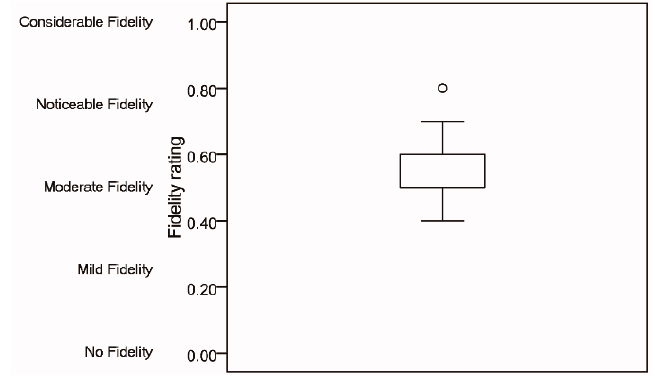
Figure 7. Fidelity ratings.